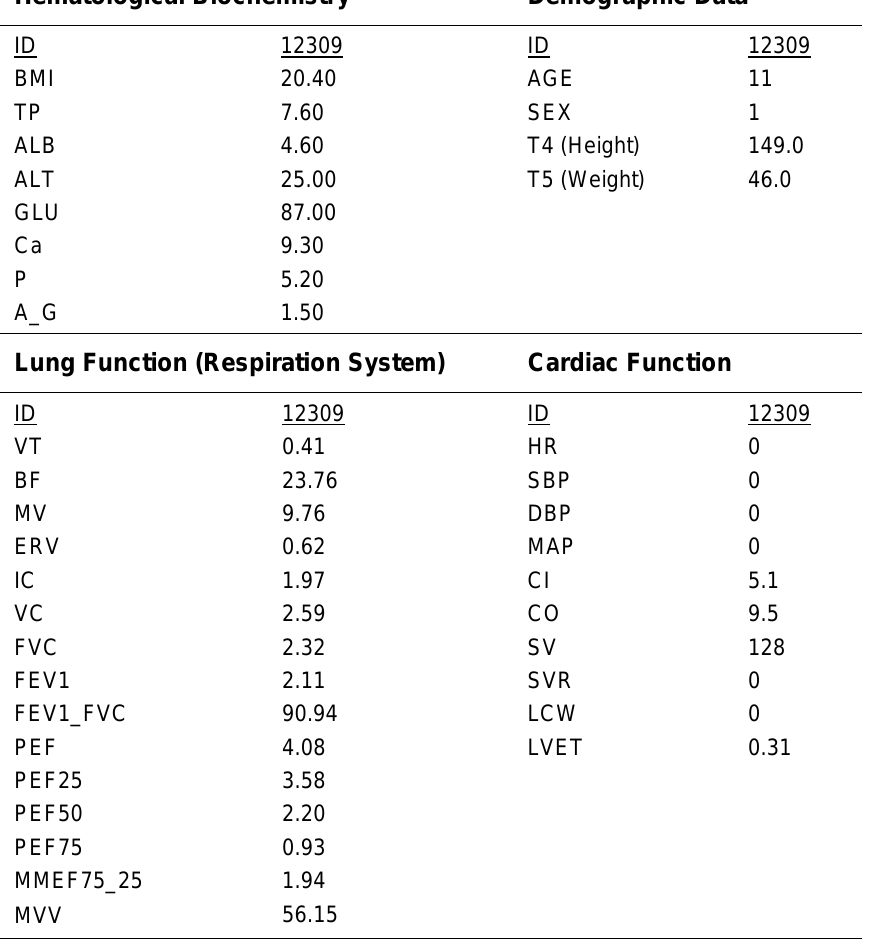
The Abbreviated Description of Tables in Database with an Example Entry (Underlines Indicate the Primary Keys and Hyperlinks to Details) Hematological